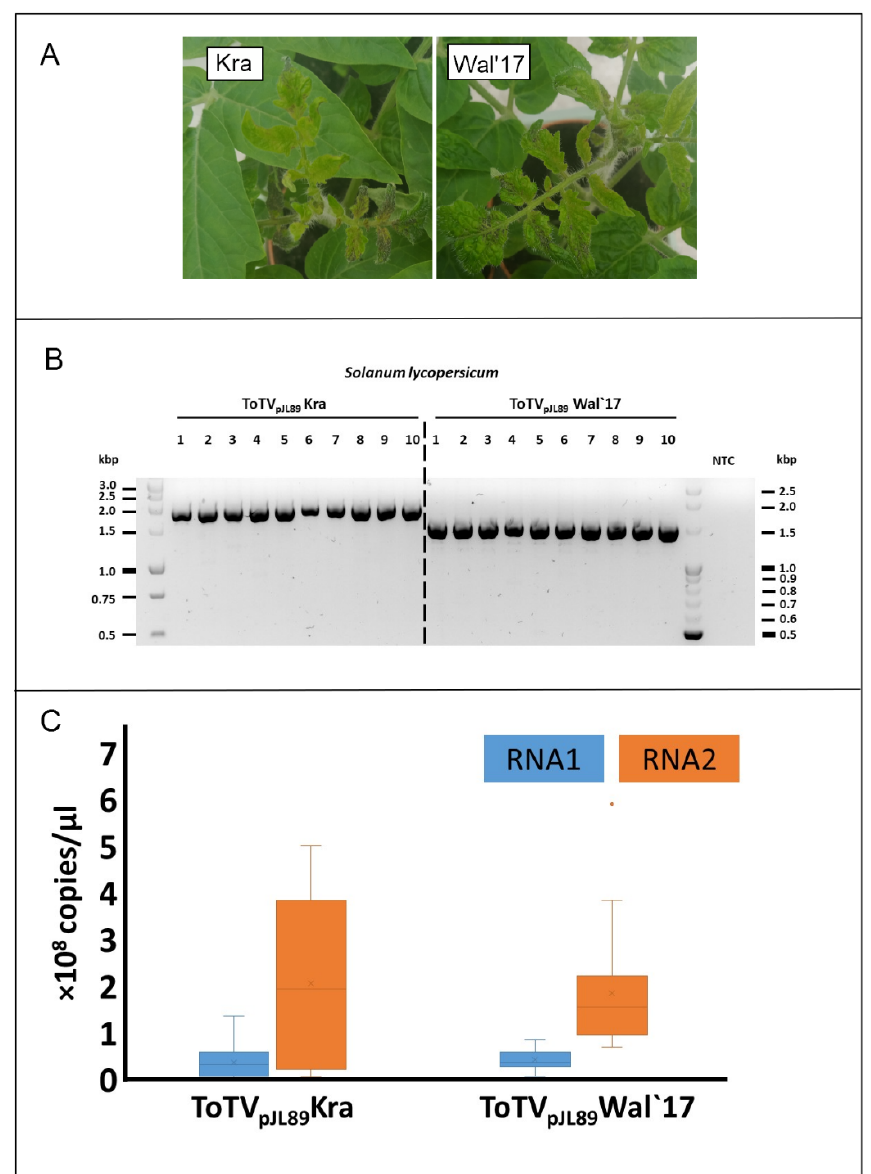
Figure 3. Symptoms induced and virus accumulation of a new isolate of tomato torrado virus isolate Wal’17. Panel ( A ): Necrotic symptoms on Solanum lycopersicum plants caused by tomato torrado virus Wal’17 (right) and Kra (left); Panel ( B ): RT-PCR detection differentiating the ToTV-Kra from ToTV-Wal`17 in infected Solanum lycopersicum . The different lengths of amplicons arose from variability within the RNA1 3’UTR region in analysed isolates; Panel ( C ): Comparison of the ToTV- Wal’17 and ToTV Kra RNA copies estimated by reverse transcription-quantitative real-time polymerase chain reaction (RT-qPCR).